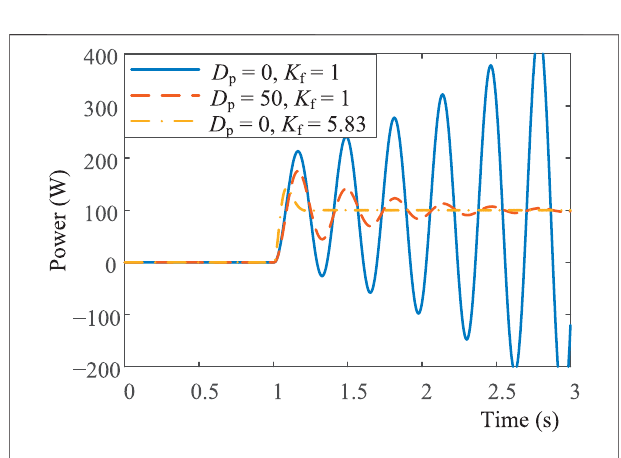
FIGURE 9 | Simulated 100 W step-up active power responses of GFMCs with different